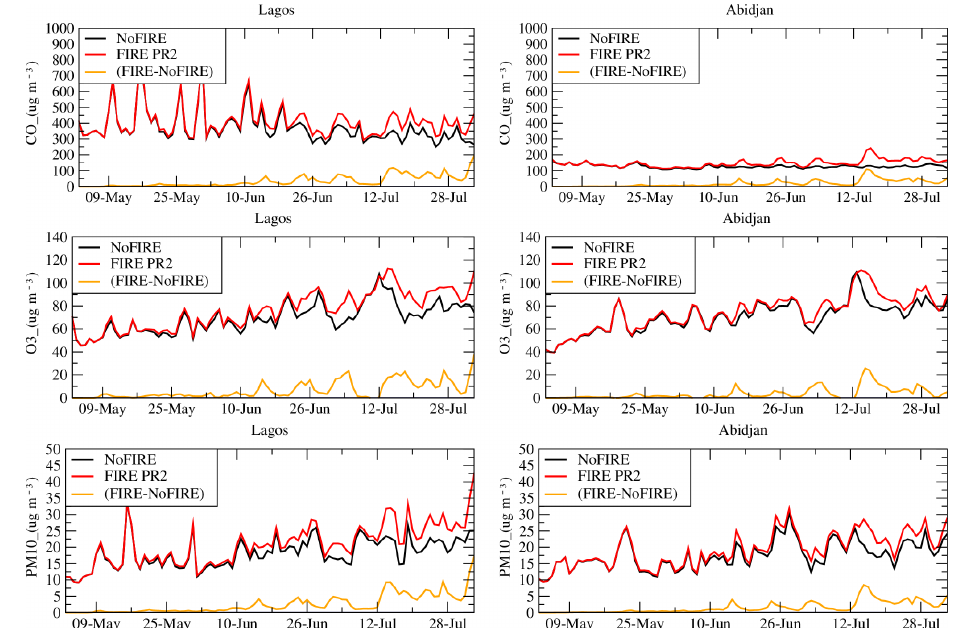
Figure 9. Time series of surface concentrations (in µgm − 3 ) of CO, O 3 , and PM 10 . Results are presented for Lagos and Abidjan and for the simulations NoFIRE and FIRE